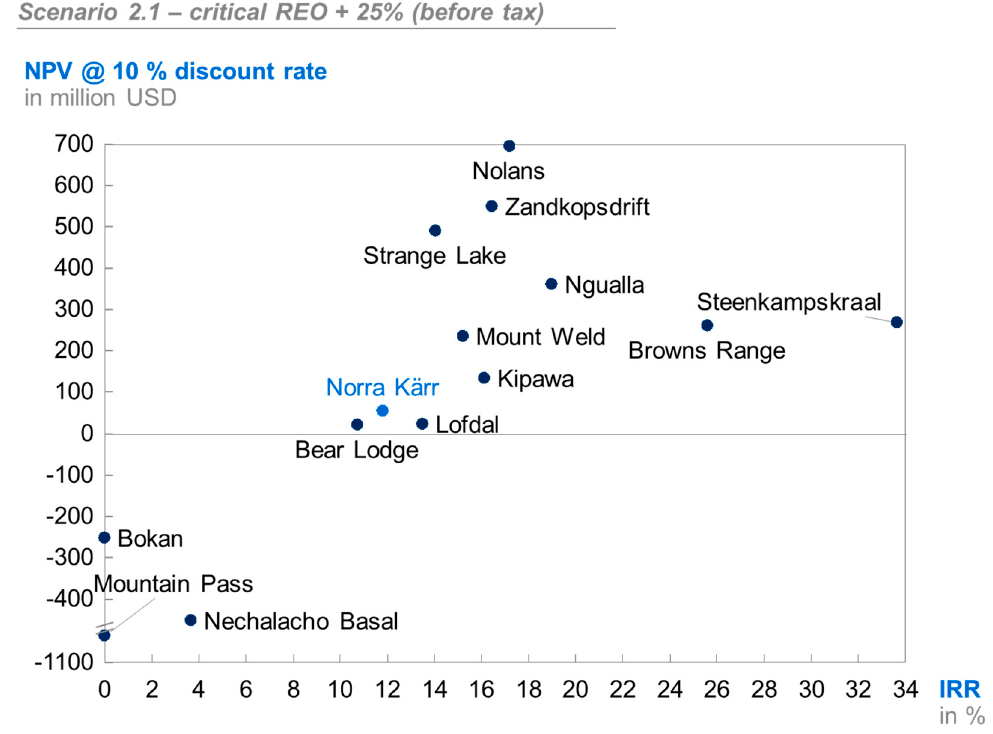
Figure 4. Results of the DCF model at a 10% discount rate (pre-tax) and based on a 25% price increase of critical REOs.